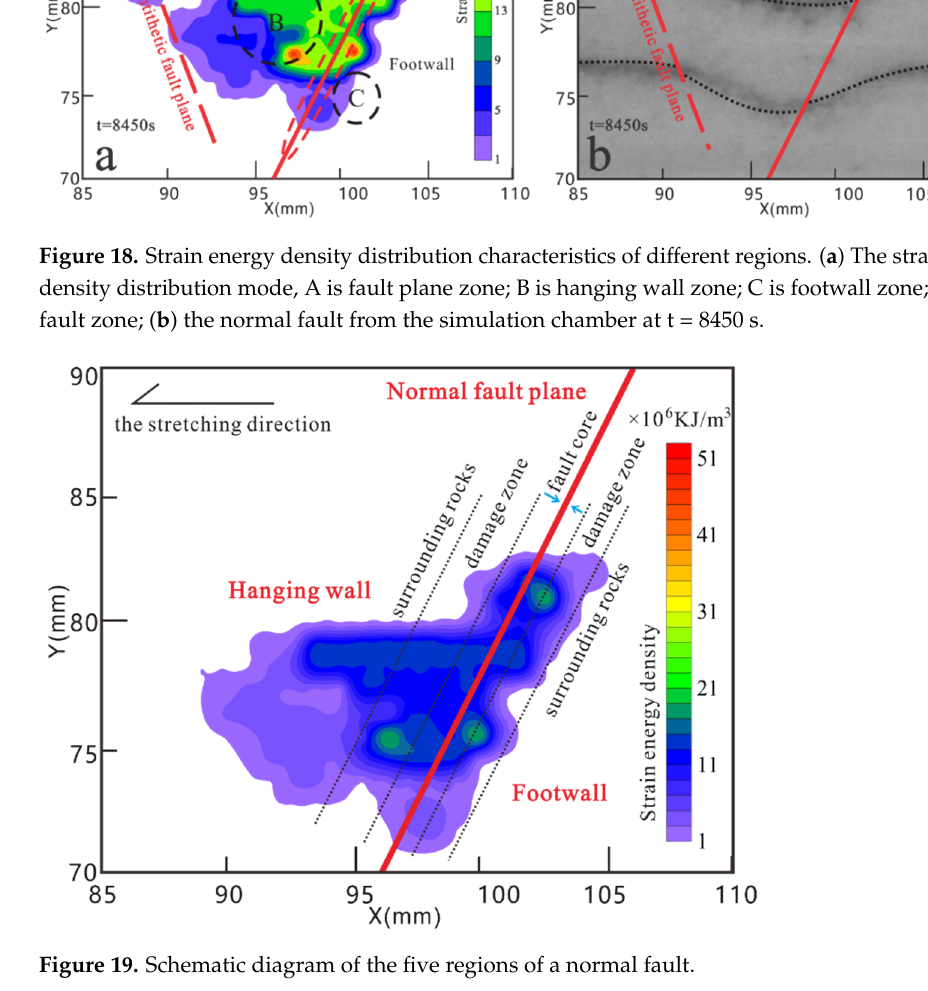
Figure 18. Strain energy density distribution characteristics of different regions. ( a ) The strain en- ergy density distribution mode, A is fault plane zone; B is hanging wall zone; C is footwall zone; D is new fault zone; ( b ) the normal fault from the simulation chamber at t = 8450 s. Table 5. Range conversion table for each region of the normal fault in the prototype and experi- ment (L* = 2 × 10 − 5 ).